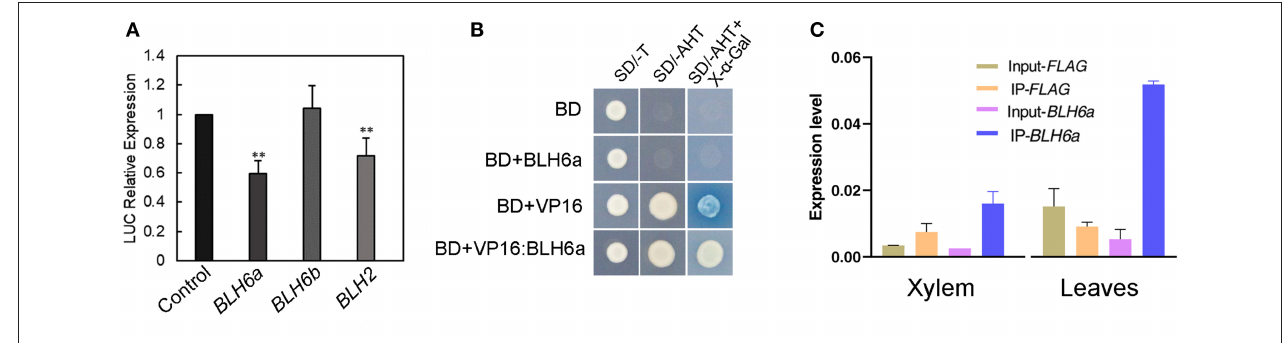
FIGURE 3 | BLH6a is a transcriptional repressor of CAld5H2 in P. alba × P. glandulosa . (A) Effector-reporter-based gene activation/repression assay. LUC gene was driven by the P. alba × P. glandulosa CAld5H2 promoter in the reporter construct. Each TF gene from P. alba × P. glandulosa was driven by the 35S promoter in the effector construct. Effect construct and reporter construct were co-infiltrated in the tobacco leaves by Agrobacterium for the LUC activity determination. The reporter construct alone was the control. (B) Transactivation/repressor activity detections in yeast strain Y2HGold. SD/-T, single dropout medium lacking tryptophan; SD/-AHT, triple dropout medium lacking adenine, histidine, and tryptophan; BD, GAL4-binding domain. (C) Chromatin immunoprecipitation (ChIP) assays in xylem (left) and leaf (right) protoplasts. ChIP was conducted in protoplasts overexpressing FLAG and FLAG:BLH6a , respectively, and followed by qPCR. Input-FLAG and Input-BLH6a were IP using one-fiftieth of the supernatants before adding antibodies in the FLAG and FLAG:BLH6a overexpression protoplasts, respectively. IP-FLAG and IP-BLH6a were IP with FLAG antibodies in FLAG and FLAG:BLH6a overexpression protoplasts, respectively. Error bars represent SD ( n = 3). ** p < 0.01, determined by Student’s t test.